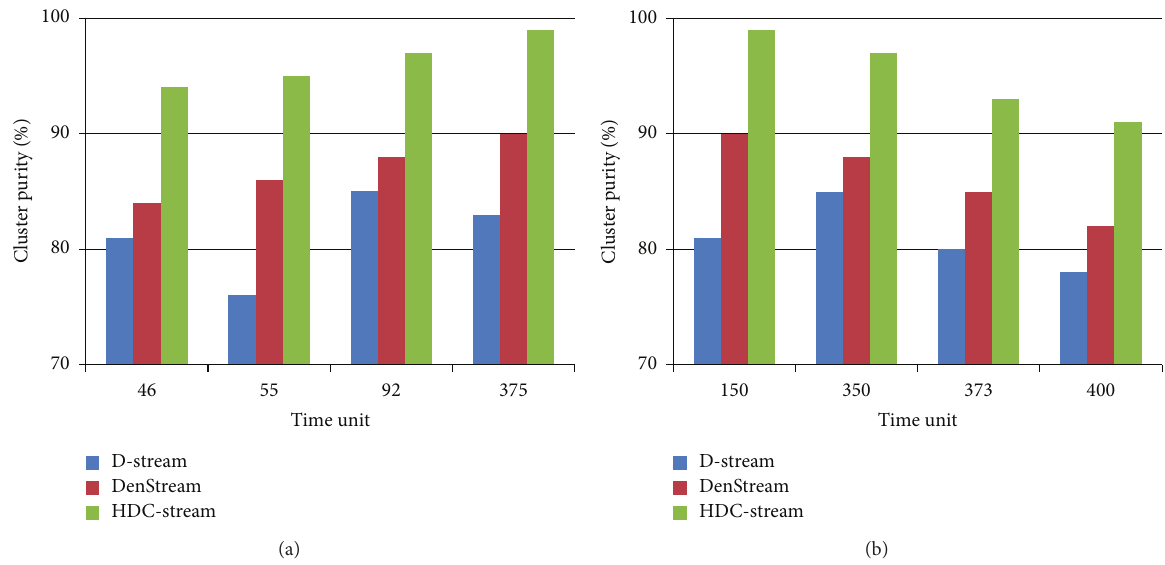
Figure 7: Cluster purity of HDC-Stream for Network Intrusion Detection dataset with (a) horizon = 2 and stream speed = 1000 and (b) horizon = 5 and stream speed =